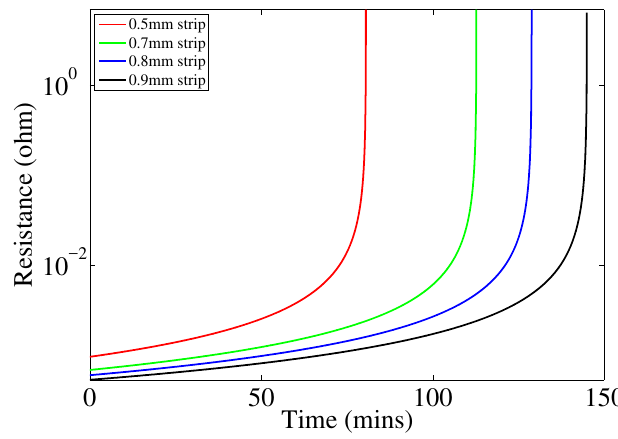
Figure 5. Resistance of sensing strips vs. experiment